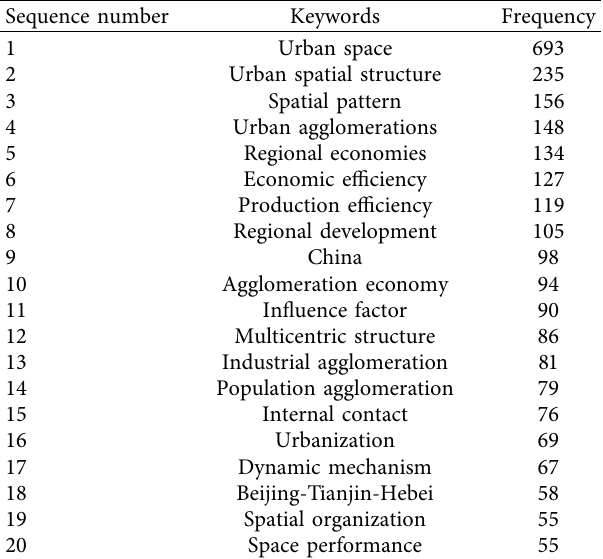
Table 1: High-frequency keywords in the field of regional spatial structure and economic